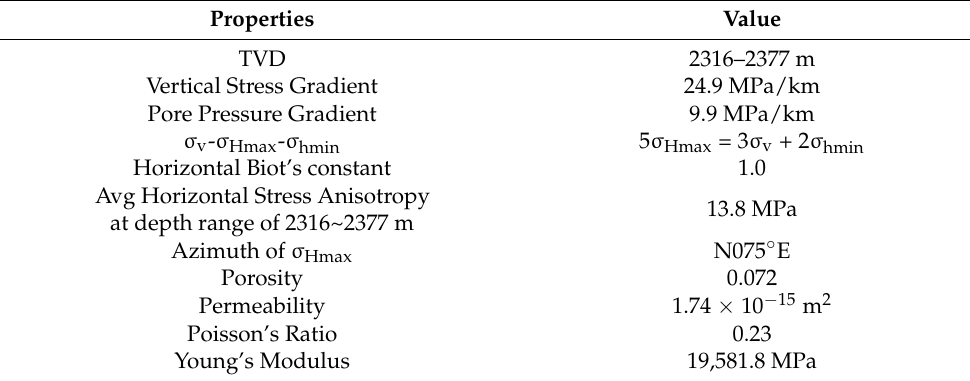
Table 1. Reservoir properties.